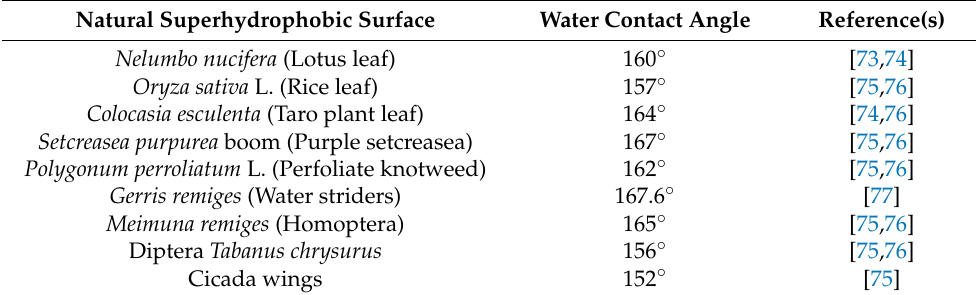
Table 3. Examples of naturally occurring superhydrophobic